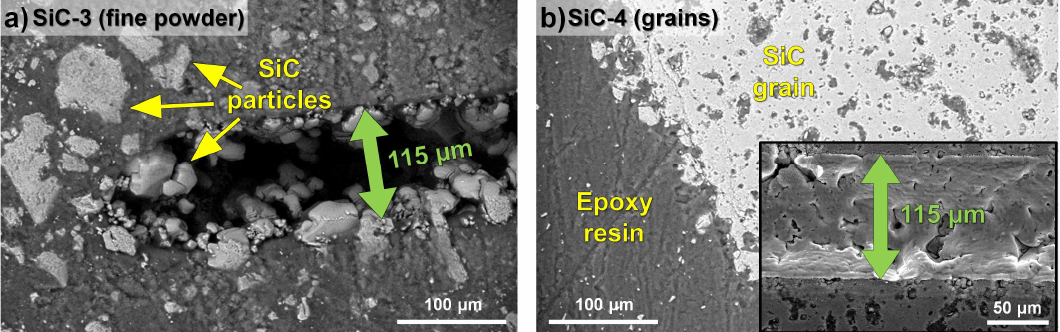
Figure 3. SEM images of craters generated by laser ablation lines on samples ( a ) SiC-3 and ( b ) SiC- 4.